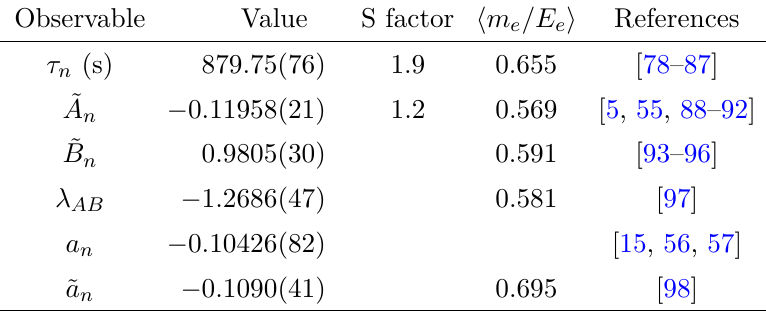
Table 9 . Inputs from neutron decay used in the